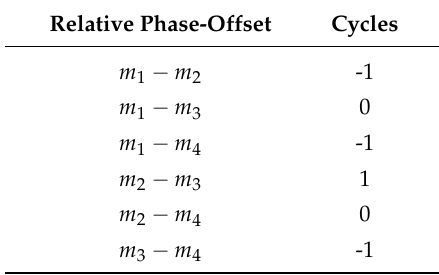
Table 1. Relative phase-offset values of artificially disconnected